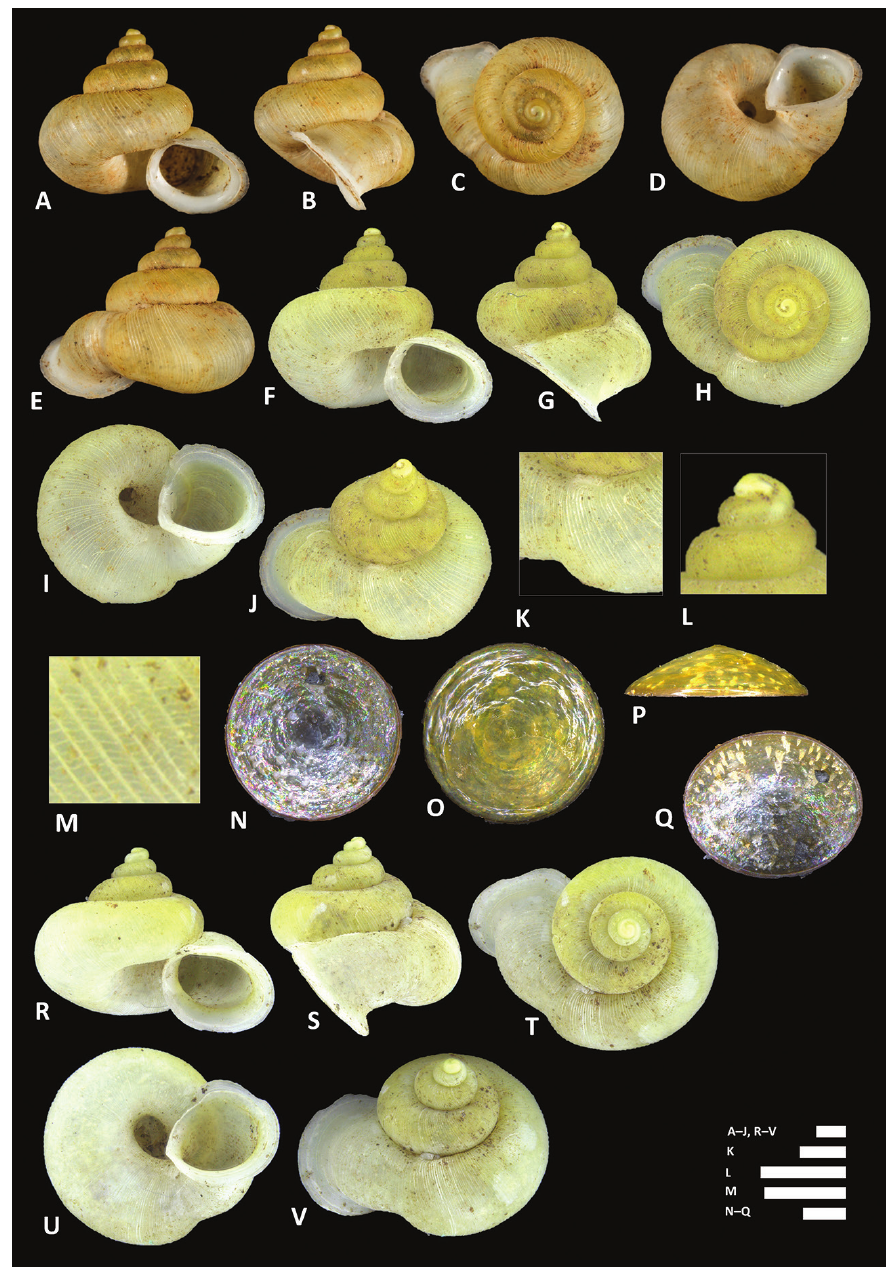
Figure 24. Alycaeus perakensis Crosse, 1879a. A–E Shell of syntype, MNHN-IM-2000-31793 F–J Shell of BOR/MOL 8350 K–M Close up of shell of BOR/MOL 8350 N–Q Operculum of BOR/MOL 8349 R–V Shell of BOR/MOL 8355. Scale bars: A–J, K, L, R–V 1 mm; M, N–Q 0.5 mm. Photographs A–E by Manuel Caballer (reproduced herein under CC-BY 4.0 license, Project RECOLNAT, MNHN). Photographs F–V by Junn Kitt